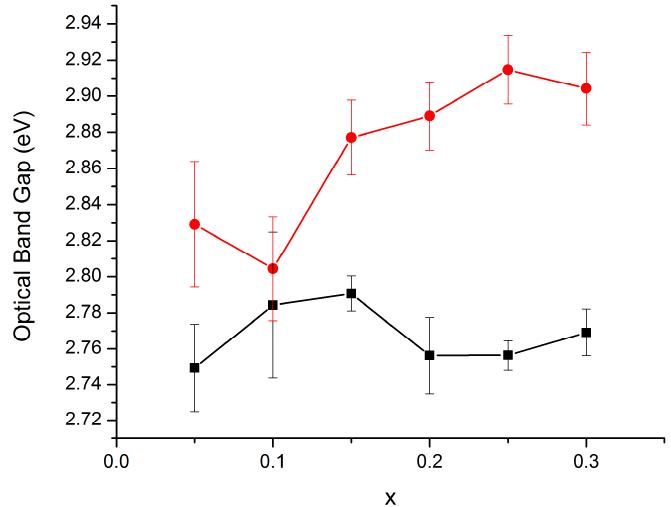
Figure 4 . Optical band gaps of the Mg x In 2 − 2x Sn x O 3 solid solution before (squares) and after (circles) reduction.